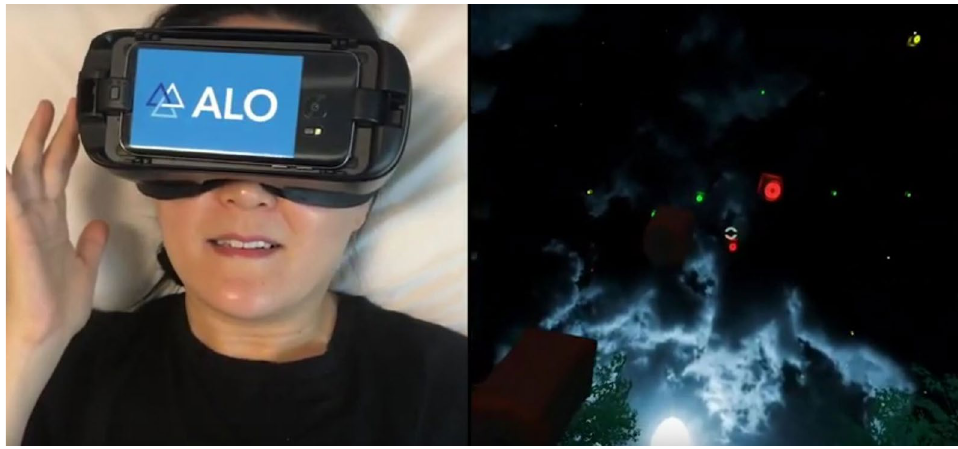
Figure 1. Picture of a user experiencing the Sky Lights 2 immersive pain distraction